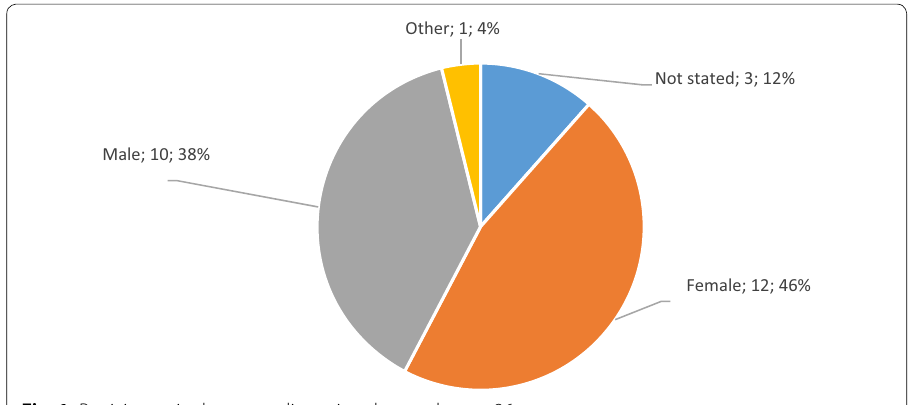
Fig. 1 Participants in the group discussions by gender, n